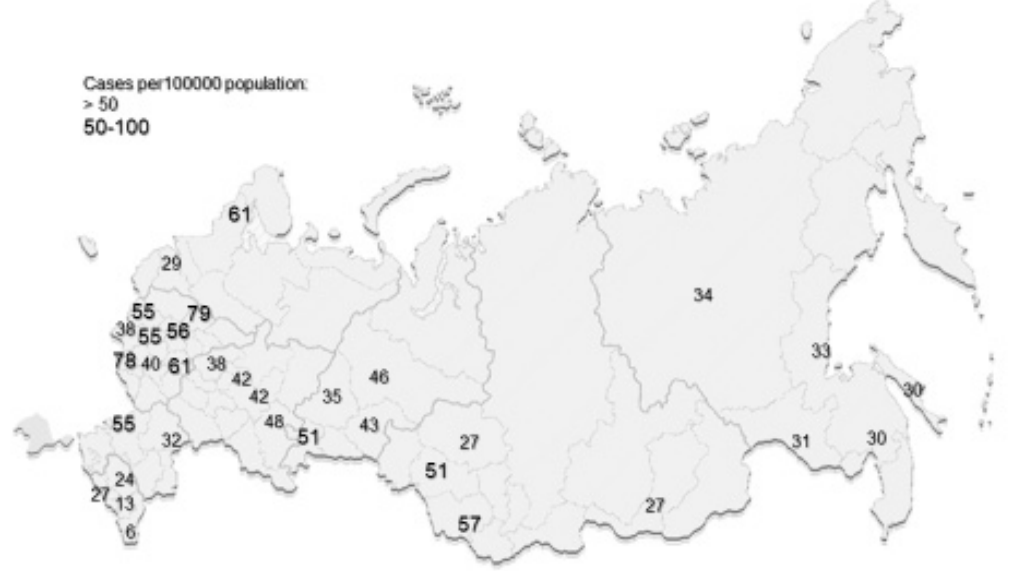
Figure 2. The latest data on MS prevalence per 100,000 population in regions of the Russian Federation.